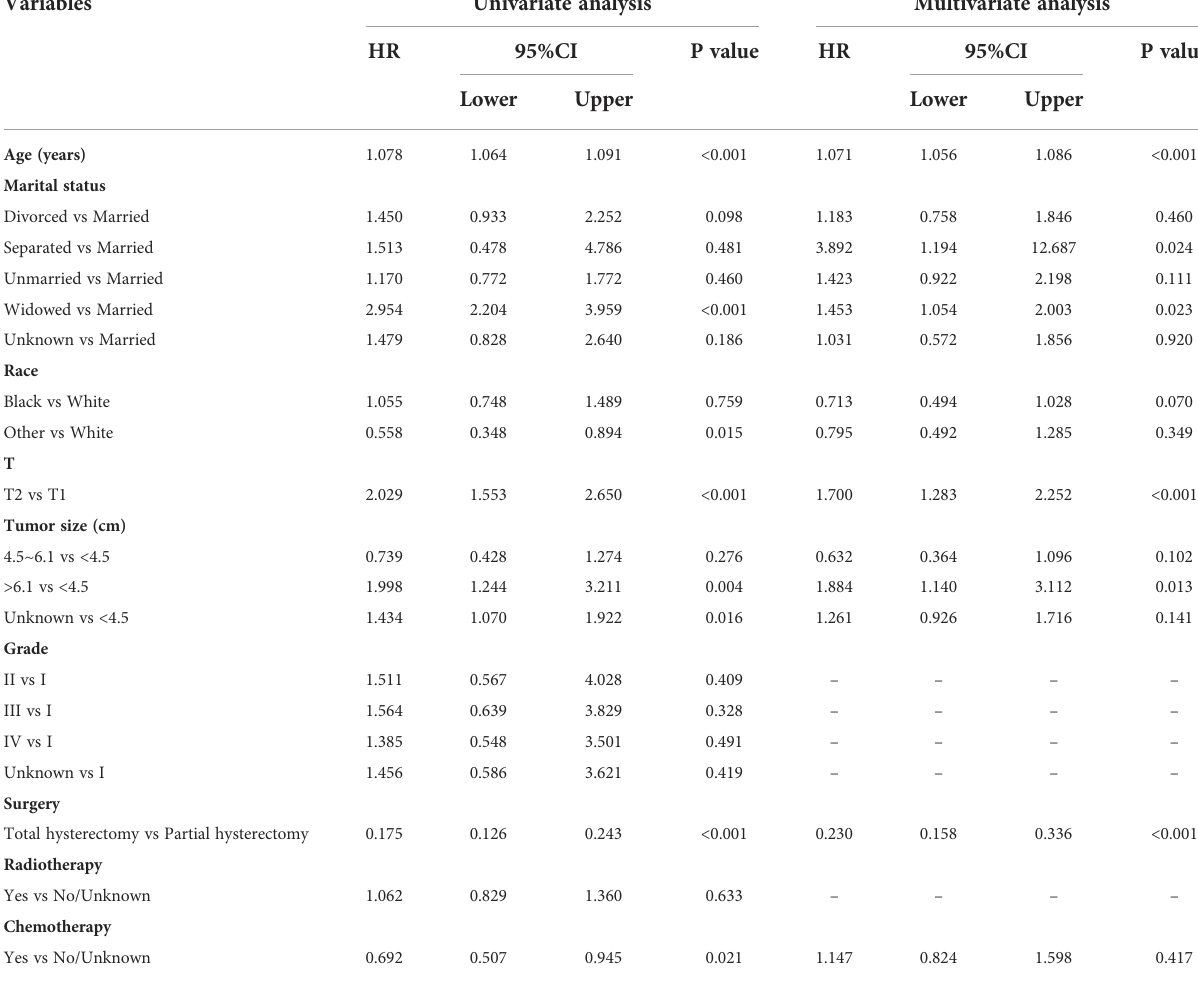
TABLE 2 Univariate and multivariate COX analyses of OS in the FIGO stage I/II training cohort.